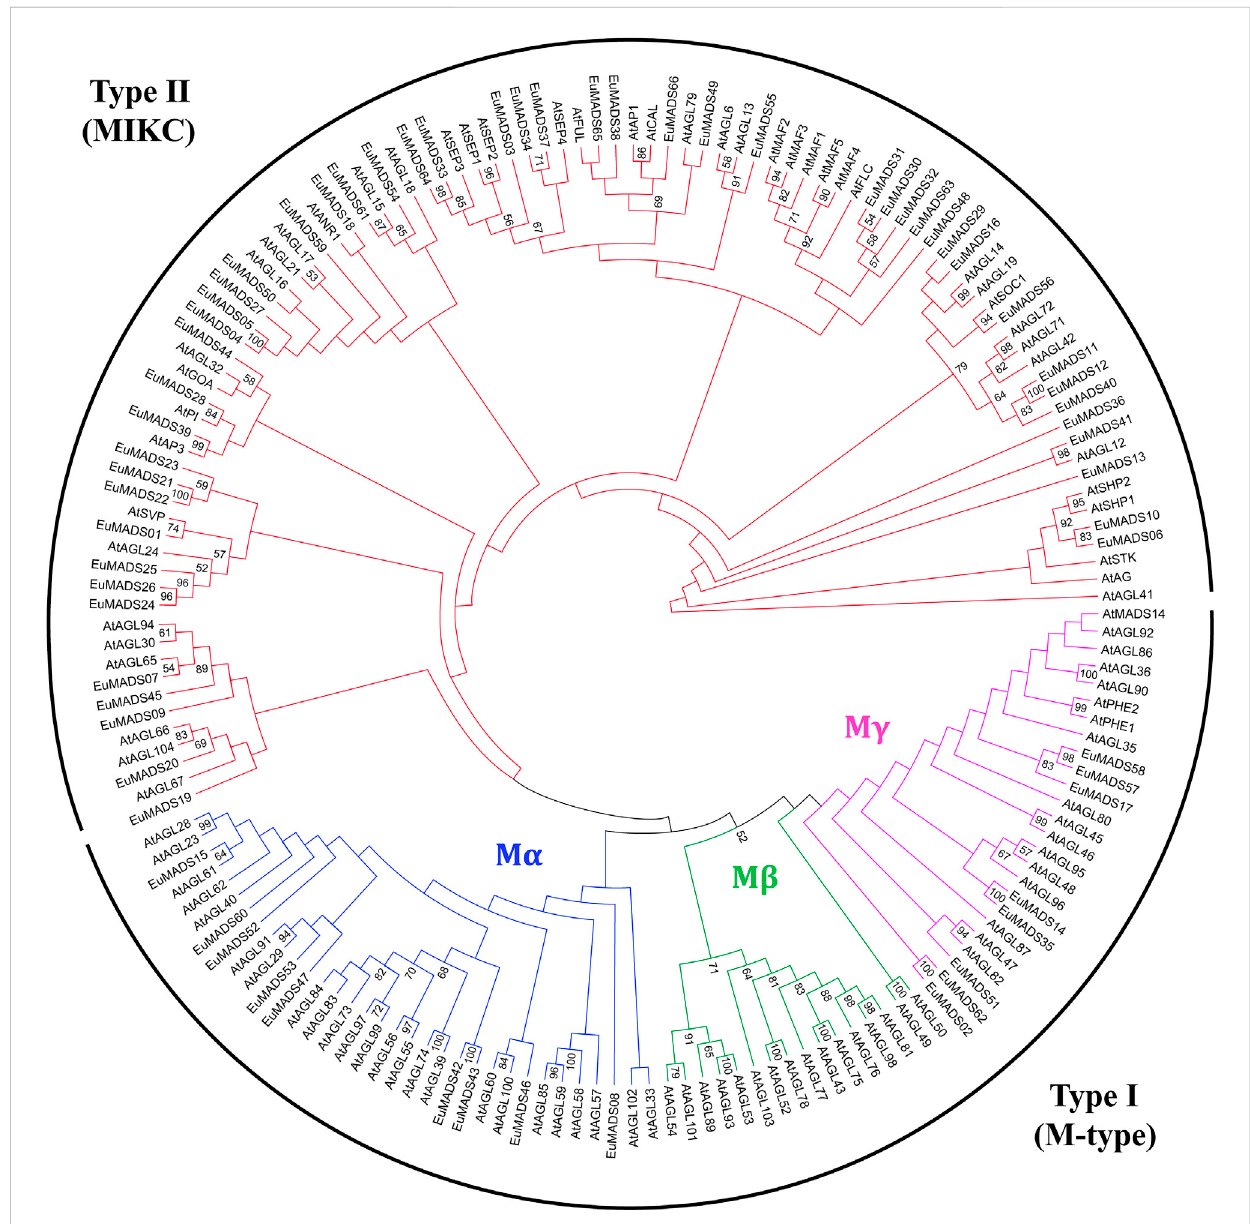
FIGURE 3 Maximum likelihood tree of MADS-box transcription factors in E. ulmoides and A. thaliana . The tree reveals two subfamilies of the MADS-box gene family, i.e., Type I (M-type) and Type II (MIKC). In M-type group, three subgroups, i.e., M α , M β and M γ are shown in blue, green and purple, respectively. MIKC group is colored in